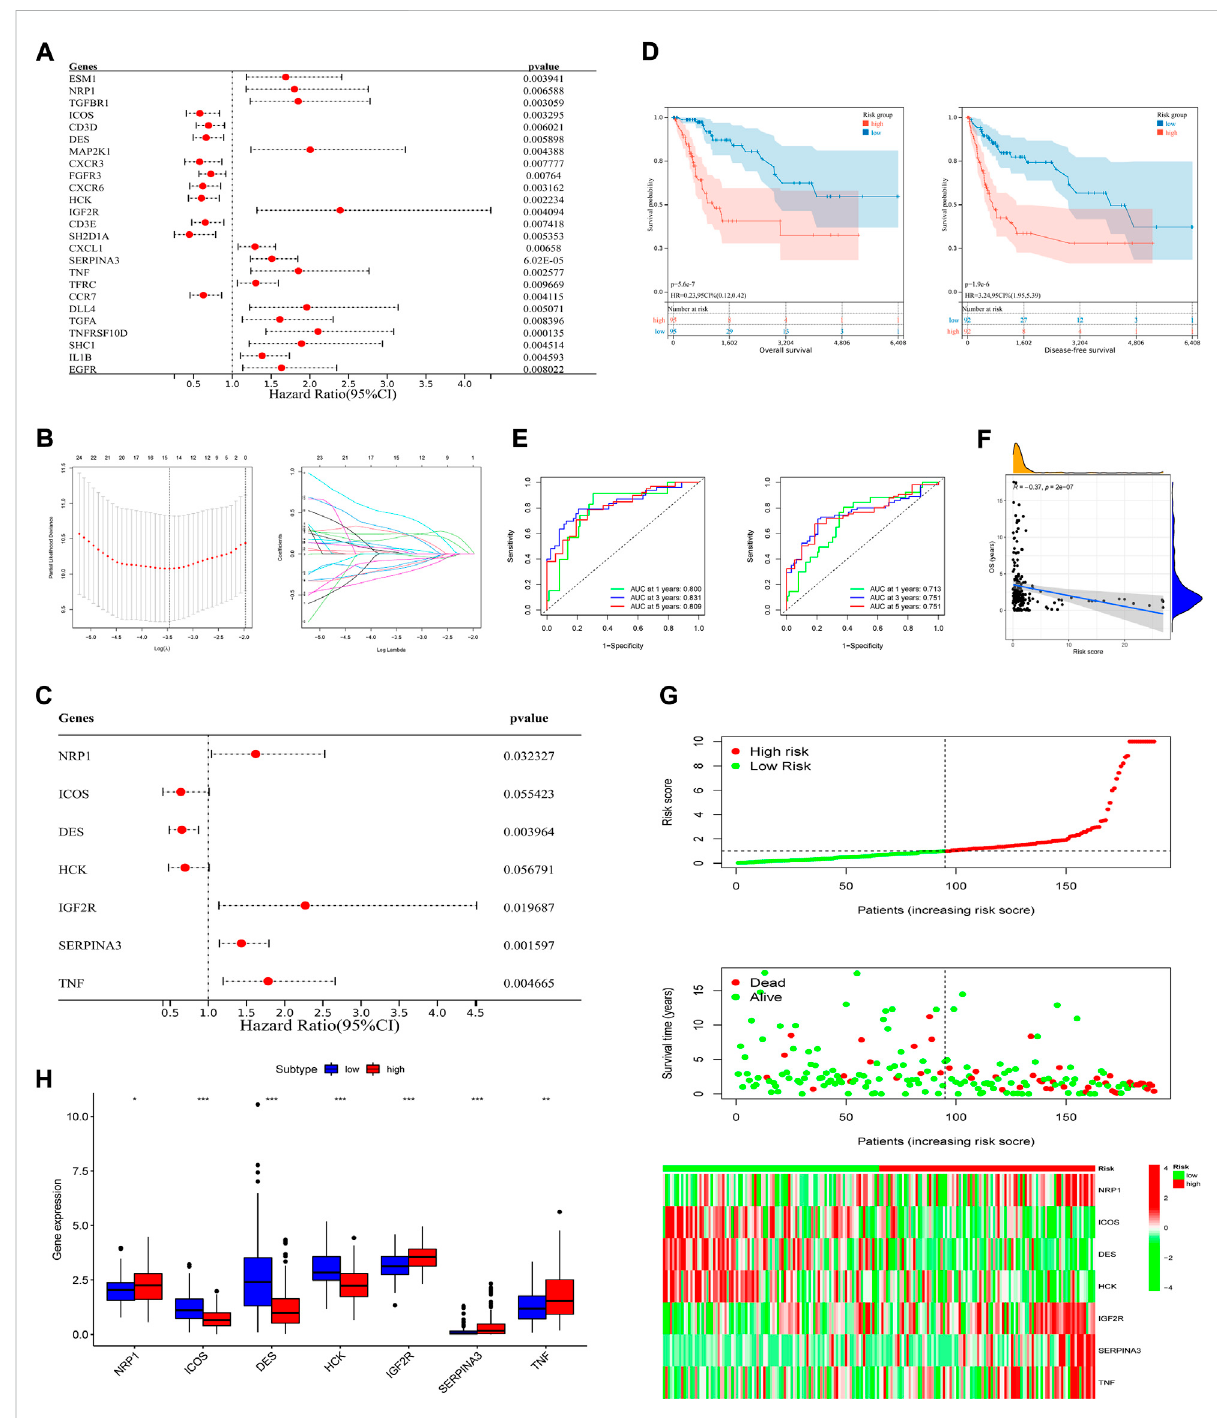
FIGURE 3 Construction of the prognostic signature and preliminary validation of its predictive power in training set. (A) Univariate Cox regression analysis of IR-DEGs in training set. (B) Select the optimal parameter (lambda) in the LASSO model. (C) Multivariate Cox regression analysis of IR-DEGs to identify seven IR-DEGs to construct a prognostic signature. (D) OS curves (left) and DFS curves (right) of high- and low-risk groups separated by the signature in training set. (E) Survival-dependent ROC curves of the training set corresponding to 1-, 3-, and 5-year OS (left) and DFS (right). (F) ThecorrelationbetweenOSandriskscoresintrainingset. (G) Theriskscoredistribution,survivalstatusofpatients,andexpressionheatmapofseven signature genes (from top to bottom). (H) Boxplot of expression levels of each gene of the signature in different risk groups in training